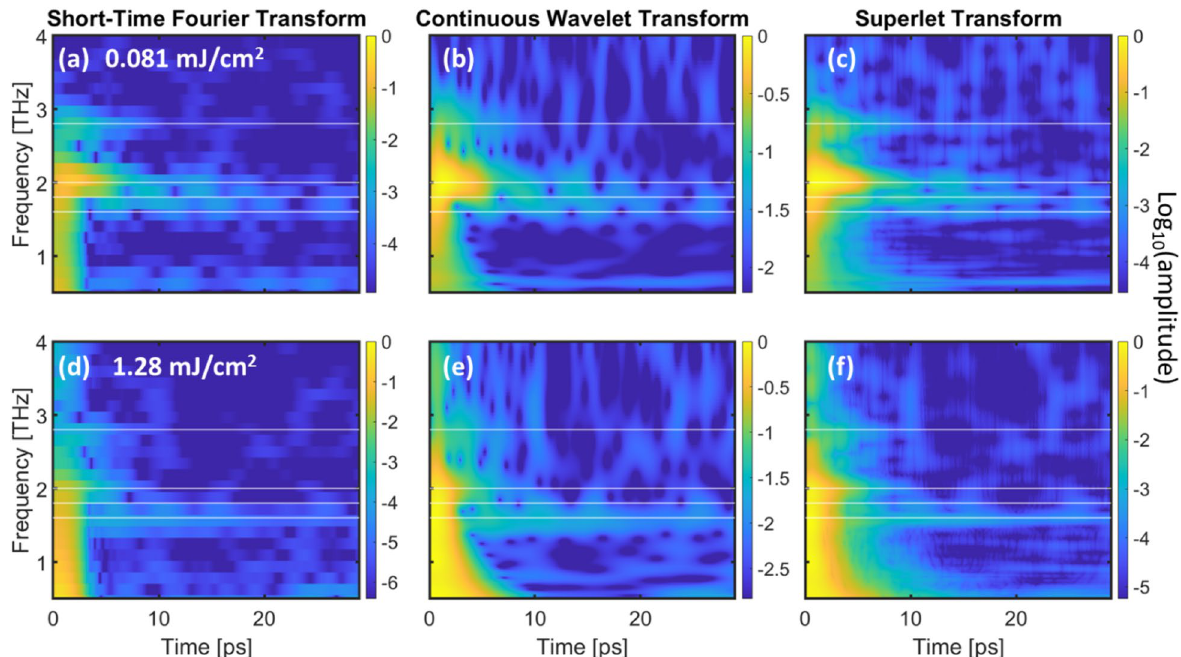
Figure 2. Comparison of the Short-Time Fourier Transform (STFT), Continuous Wavelet Transform (CWT), and Superlet Transform (SLT) for 0.081 mJ/cm 2 pump fluence ( a – c , respectively) and for 1.278 mJ/cm 2 pump fluence ( d – f , respectively). White lines at 1.6, 1.8, 2, and 2.8 THz are guides to the eye. All transforms use a normalized Log 10 color scaling for ease of comparison. The SLT outperforms the other two techniques in both spectral and temporal